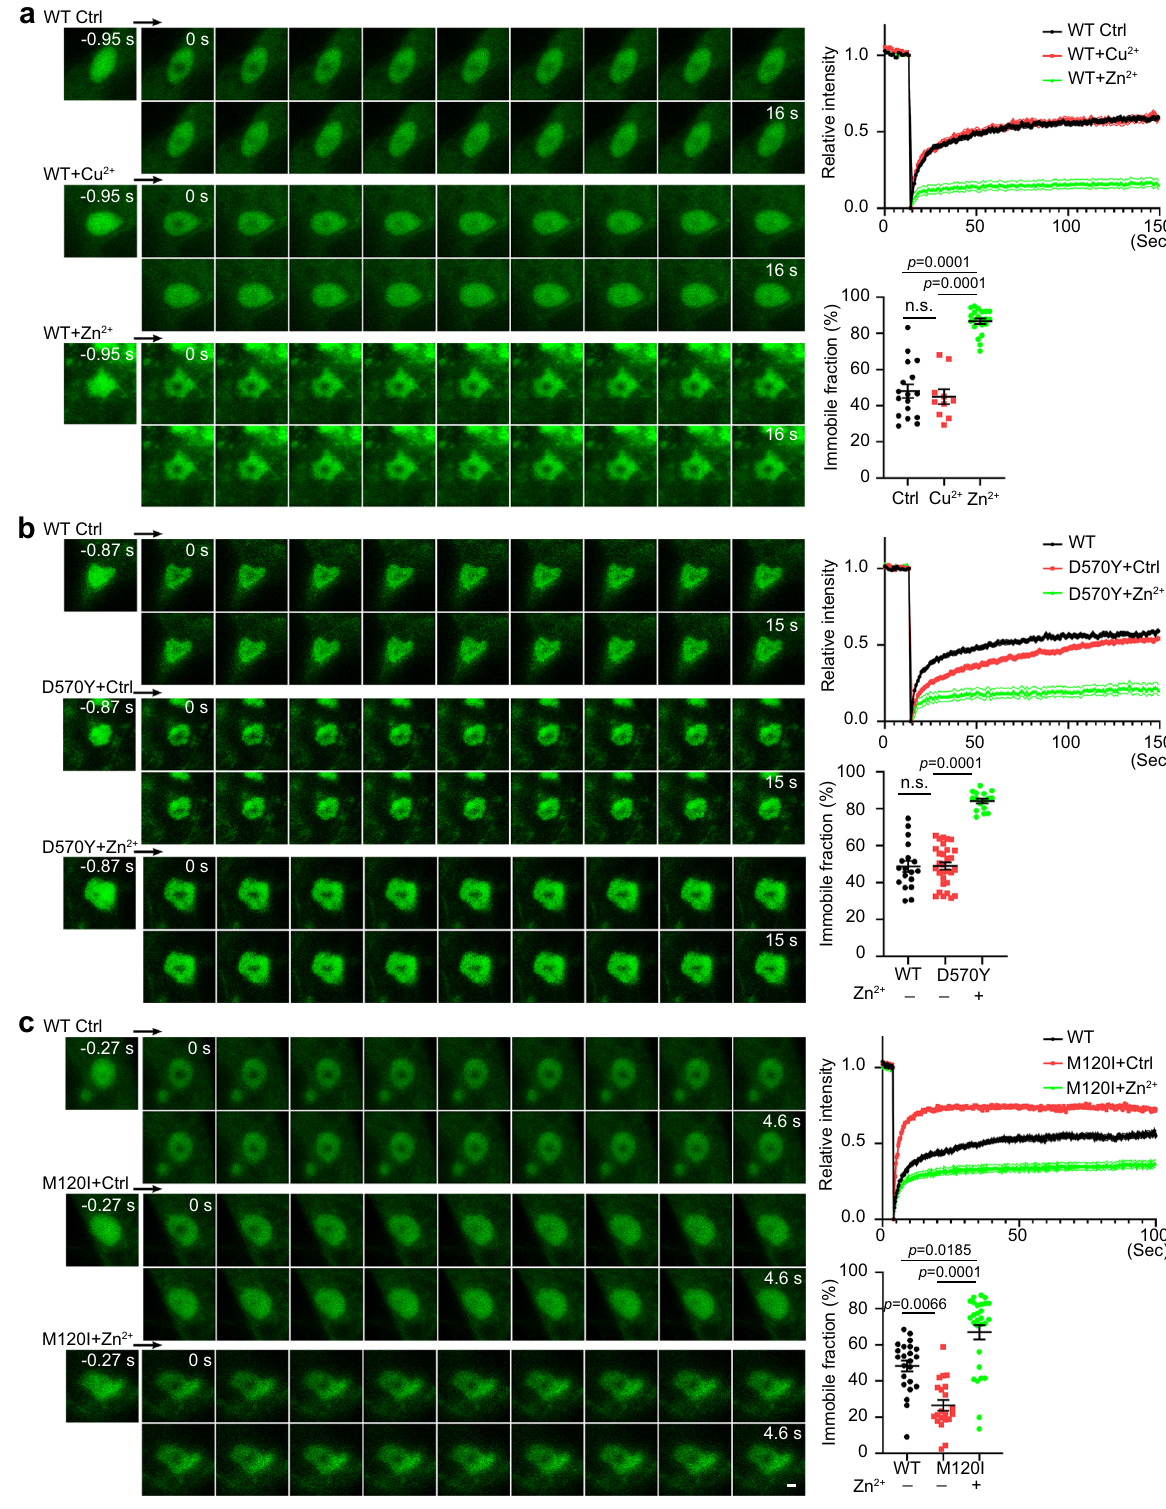
Fig. 3 Zinc and ASD-linked mutations alter CTTNBP2 mobility in COS1 cells. a WT GFP-CTTNBP2. b GFP-CTTNBP2 D570Y mutant. c GFP-CTTNBP2 M120I mutant. FRAP was performed to analyze the protein mobility of GFP-tagged WT and mutant CTTNBP2, as indicated, in COS1 cells. ZnSO 4 or CuSO 4 (1 mM) was added to culture medium 30 min before photobleaching as indicated to assess their effects. Black arrow indicates the direction of the live- imaging time-series. Normalized fl uorescence intensity and the immobile fraction are shown in the plots at right. For immobile fraction plots,